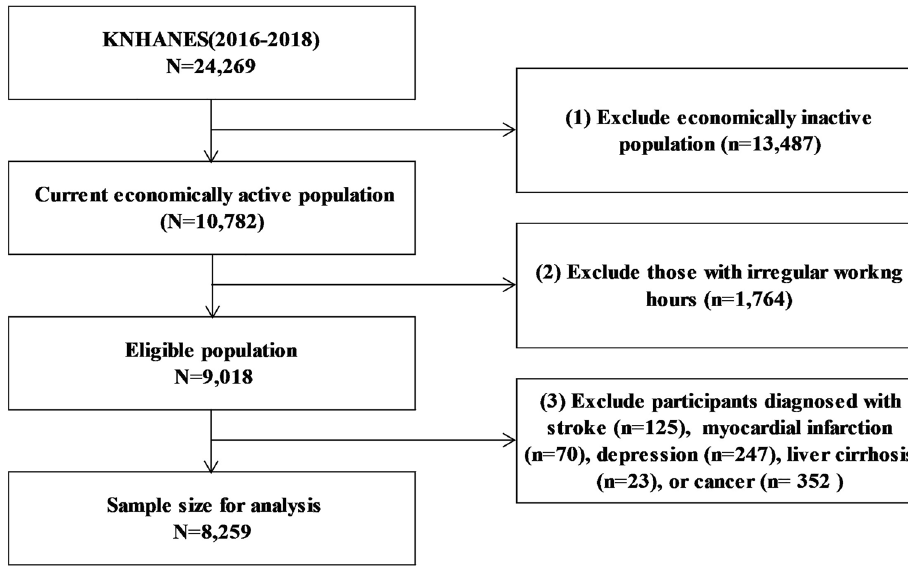
Figure 1. Schematic diagram depicting the selection of the study